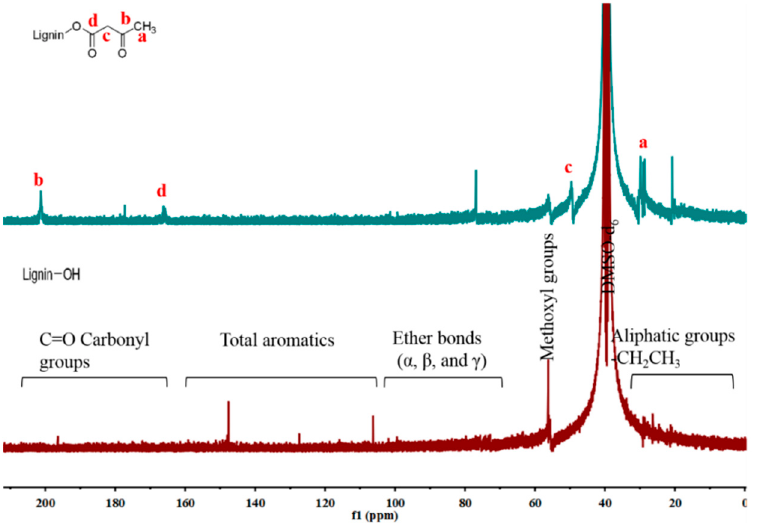
Figure 3. The 13 C NMR spectra of Ac-lignin, At-lignin, and By-lignin.